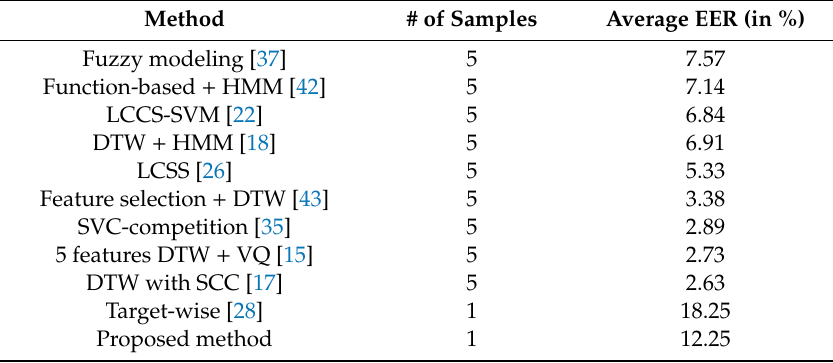
Table 8. Comparative studies of state-of-the-art methods implemented on